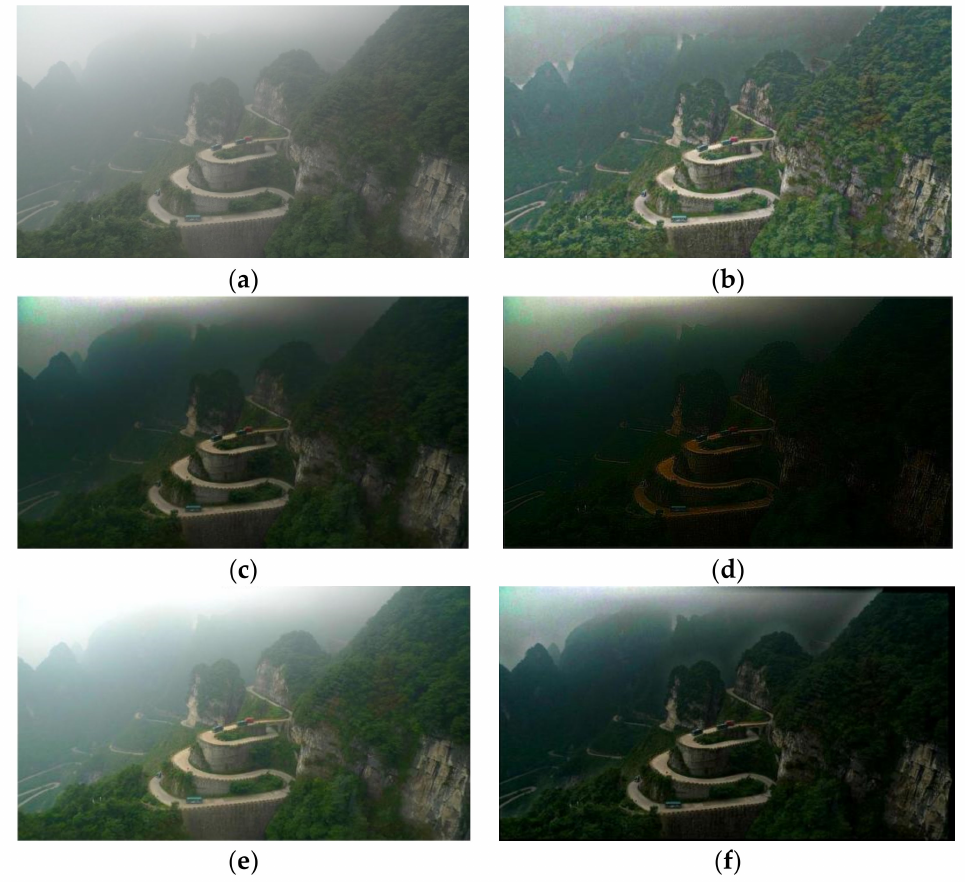
Figure 14. A comparison of defogging effects of the image of winding mountain road with fog. ( a ) Image of foggy winding mountain road image; ( b ) Tarel’s method; ( c ) He’s method; ( d ) Tufail ’s method; ( e ) Gao ’s method; ( f ) our